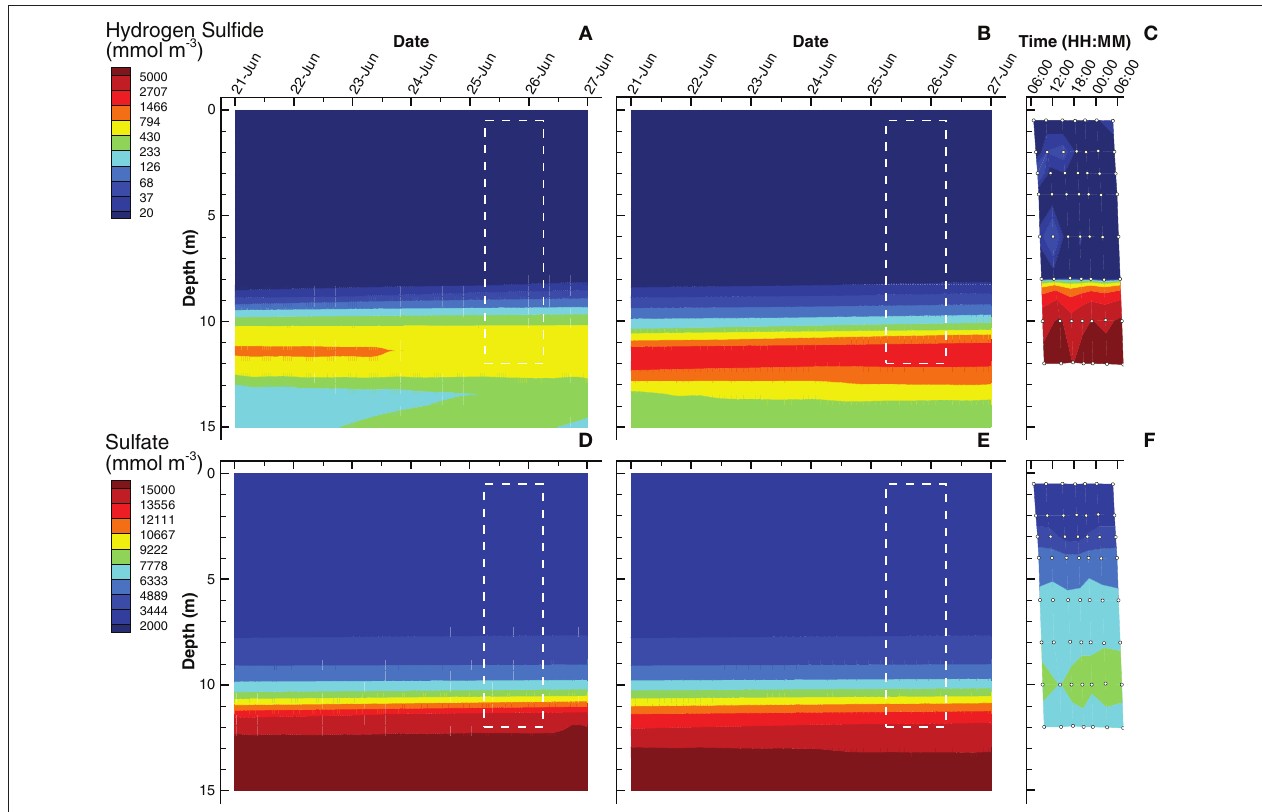
FIGURE 5 | Contour plots of hydrogen sulfide (A–C) and sulfate (D–F) concentrations for SIO and LIO simulations (left and center columns, respectively) and Siders Pond observations (right column). See caption to Figure 3 for other details.